Question: How would you classify this visualization?
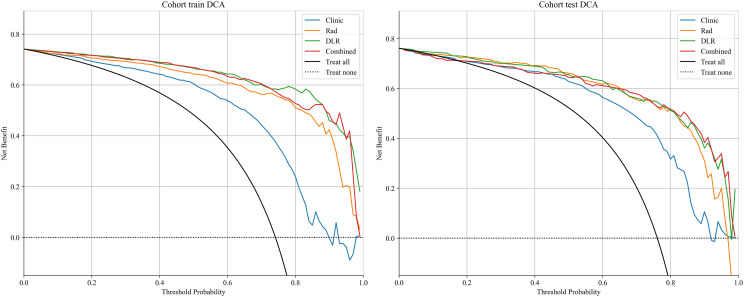
Answer: line